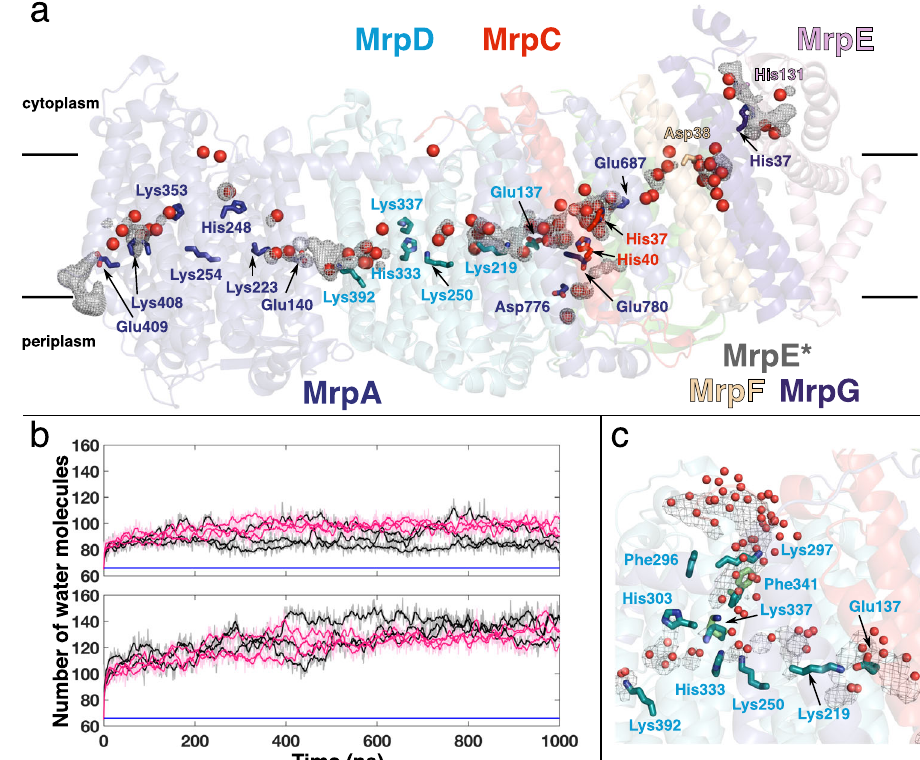
Fig. 4 | Hydration of Mrp antiporter complex. a Overall internal hydration in simulation state P, where the protonation state of amino acids is based on pKa calculation, is shown as water occupancy map calculated from all PB1 simulation replicas (dark grey mesh at 20 % isovalue). Internal structural waters (compare Fig. 2) are shown as red spheres. Water occupancy was calculated by selecting waters within 6Å of residues displayed. b Number of internal water molecules in P (top panel) and S (bottom panel) simulation states. Only waters within 6Å of residuesdisplayedin(a)arecounted.Black/pinktracesrefertosimulationsstarted from A / B alternative conformations observed in the cryoEM structure. Blue